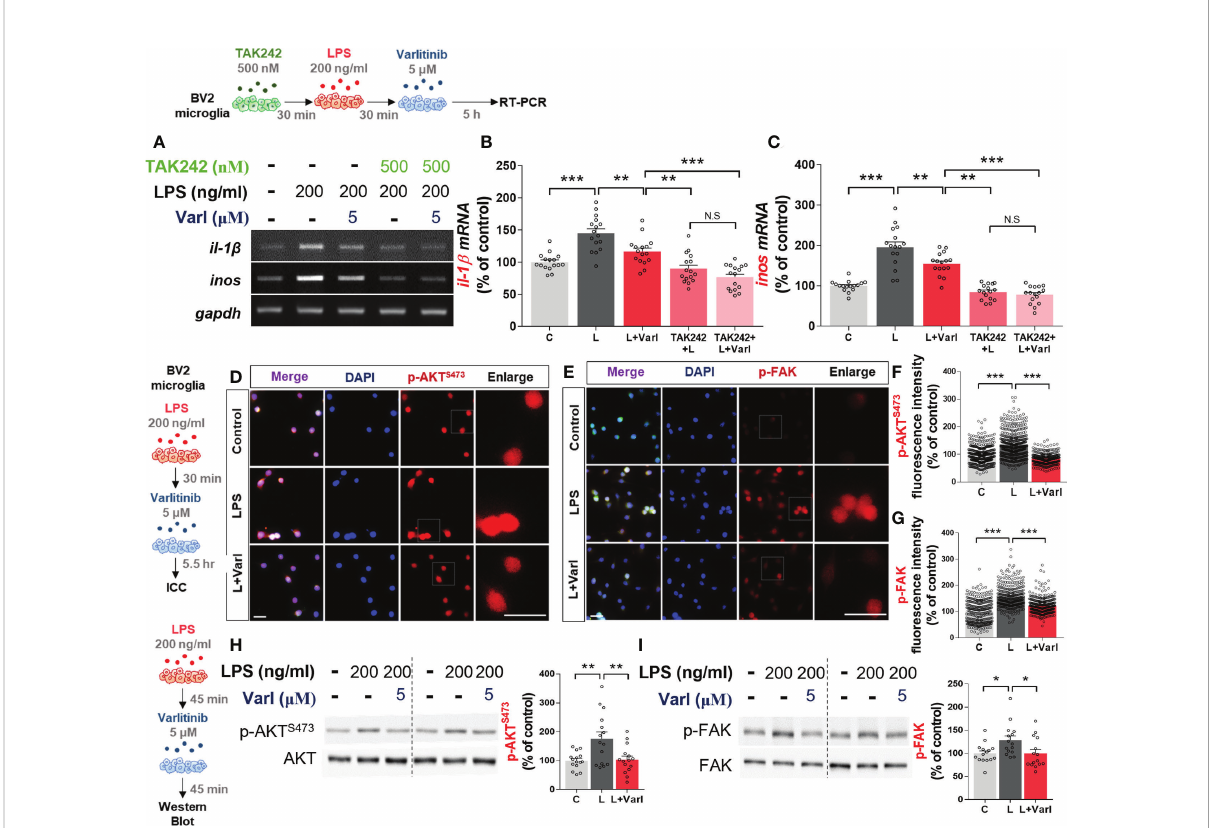
FIGURE 2 Varlitinib decreases LPS-induced AKT/FAK signaling in BV2 microglial cells. (A – C) Cells were treated with TAK242 (TLR4 inhibitor, 500 nM) or vehicle (1% DMSO) for 30 min, LPS (200 ng/ml) or PBS for 30 min, and varlitinib (5 m M) or vehicle (1% DMSO) for 5 h. il-1 b and inos mRNA levels were analyzed by RT-PCR ( il-1 b and inos : C: n = 16; L: n = 16; L+Varl: n = 16, independent biological replicates, 3 experimental replicates per group). (D – G) Cells were treated with LPS (200 ng/ml) or PBS for 45 min and varlitinib (5 m M) or vehicle (1% DMSO) for 45 min, and immunostaining was conducted with anti-p-AKT and anti-p-FAK antibodies (p-AKT, C: n = 394; L: n = 460; L+Varl: n = 326: p-FAK, C: n = 331; L: n = 332; L+Varl: n = 358, total number of examined cells). (H, I) Cells were treated with LPS (200 ng/ml) or PBS for 45 min and varlitinib (5 m M) or vehicle (1% DMSO) for 45 min, and western blotting was conducted with anti-p-AKT and anti-p-FAK antibodies (p-AKT/p-FAK, C: n = 15; L: n = 15; L+Varl: n = 15, independent biological replicates, 3 experimental replicates per group). * p < 0.05, ** p < 0.01, *** p < 0.001, C: